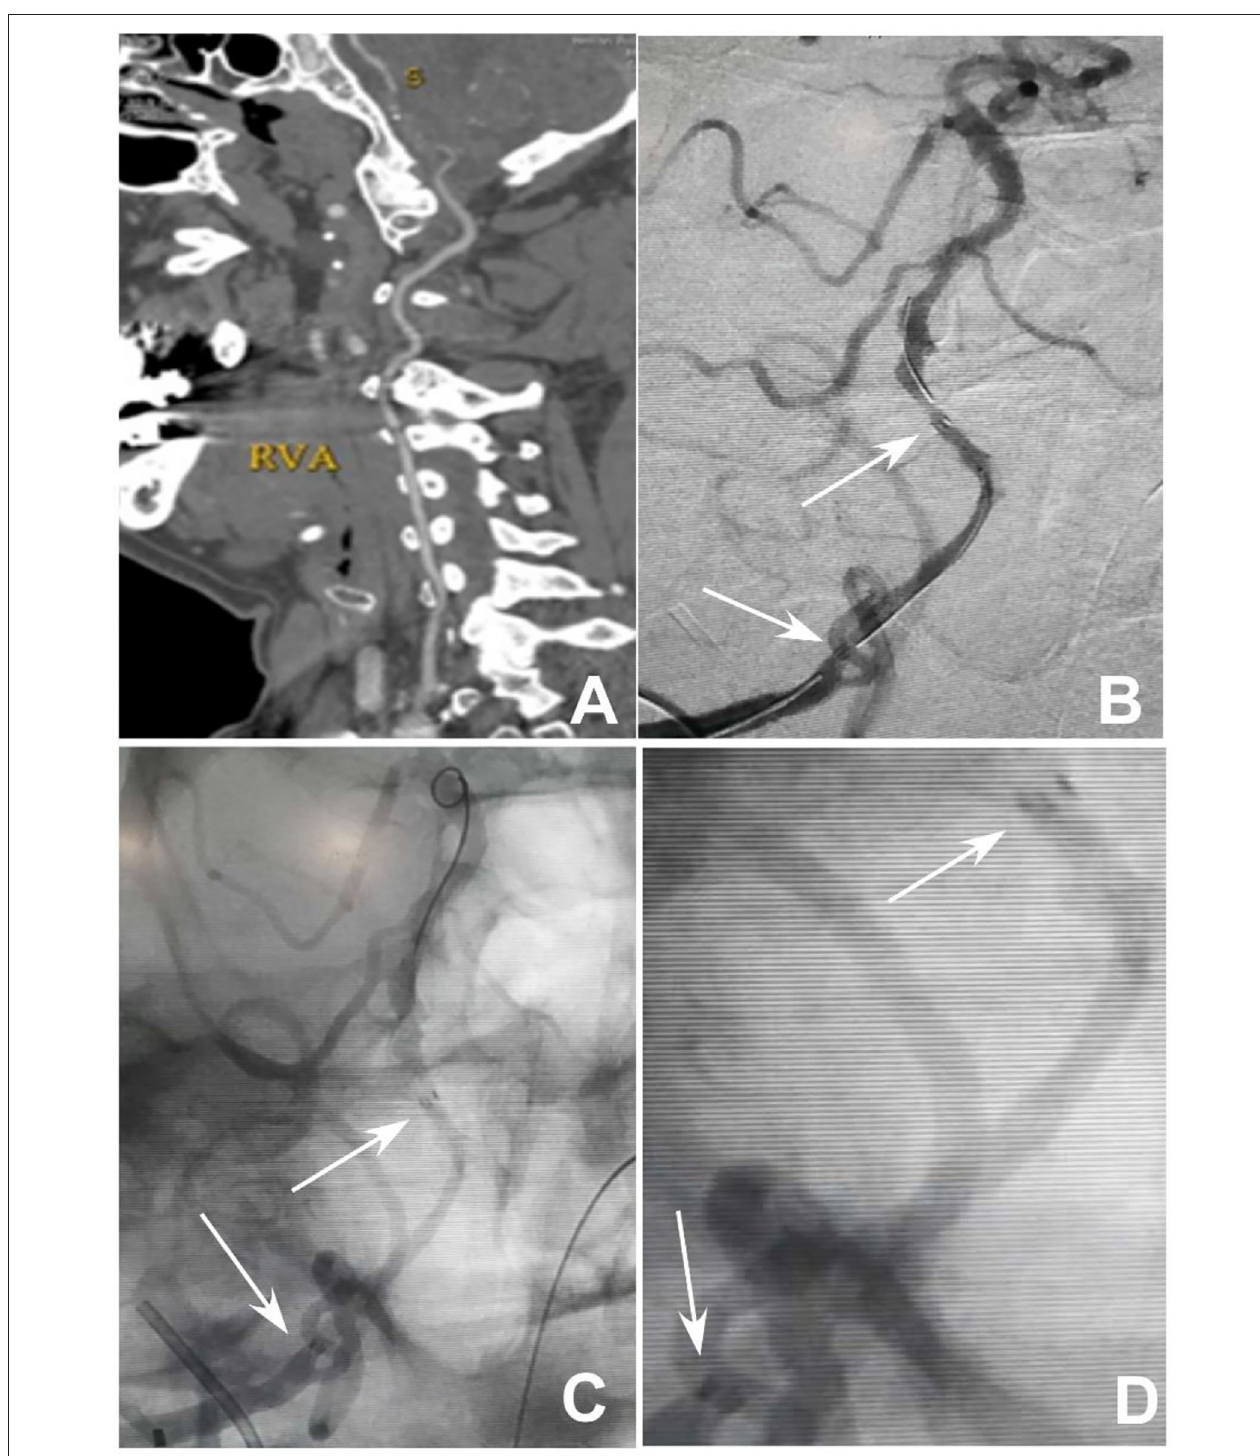
FIGURE 1 | Endovascular treatment of V4 segment occlusion of the right vertebral artery. (A) Computed tomography angiography revealed occlusion of the V4 segment of the right vertebral artery without calcification of the occluded artery. (B) After balloon expansion of the occluded segment, an Enterprise stent was deployed at the occluded segment. (C,D) After deployment of the stent with the micro-guidewire still in the artery, the proximal and distal markers of the stent were spread out with patency of the stent. (D) is the local enlargement of (C) between the proximal and distal markers of the stent. Arrows indicate the proximal and distal markers of the